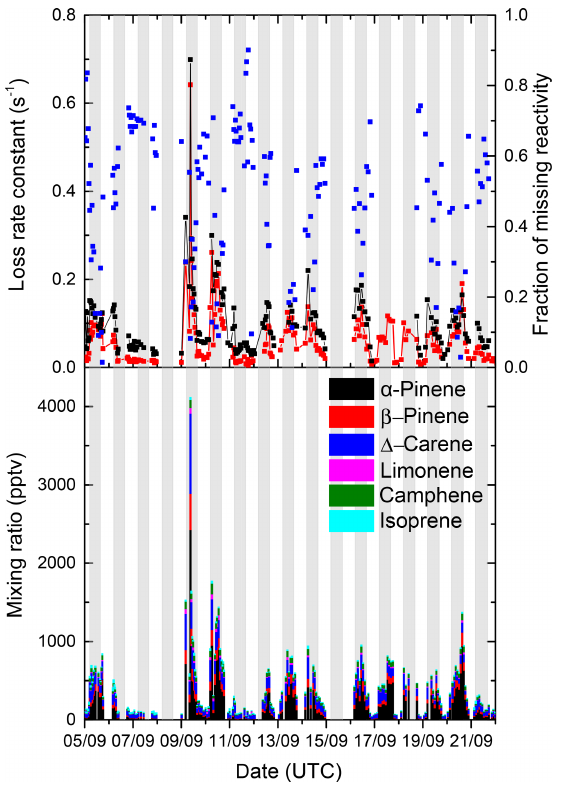
Figure 7. Upper plot: comparison of k GC-AED (red data points) and measured NO 3 reactivity ( k OTG , black data points). The fractional missing reactivity (blue data points) was calculated as ( k OTG − k GC-AED )/k OTG . Lower plot: mixing ratios of individual monoter- penes as measured by the GC-AED and their contribution to the NO 3 reactivity. The grey shaded areas represent nighttime.